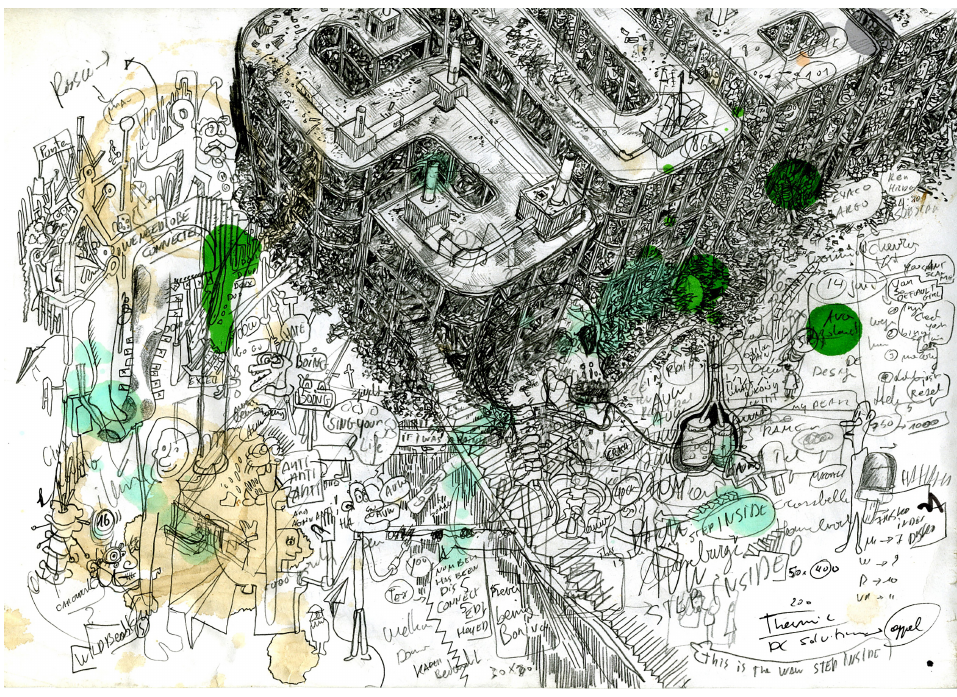
Figure 4: Andy’s comfort is becoming a ghost on your